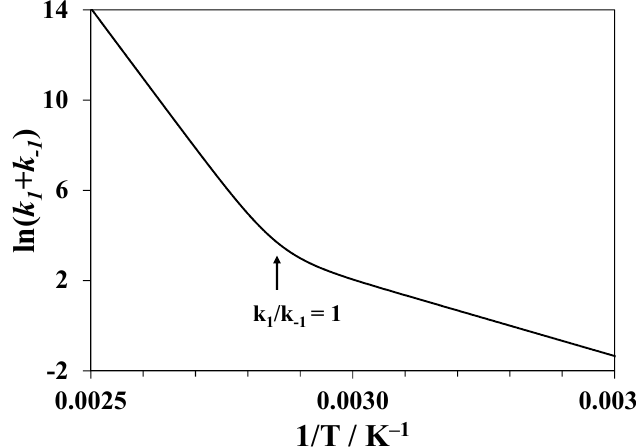
Figure 7. Results of numerical modeling for a single-step reversible process of unfolding of the tertiary structure of lysozyme in pure water: dependence of the logarithm of the sum of the rate constants of forward and reverse processes on 1 / T